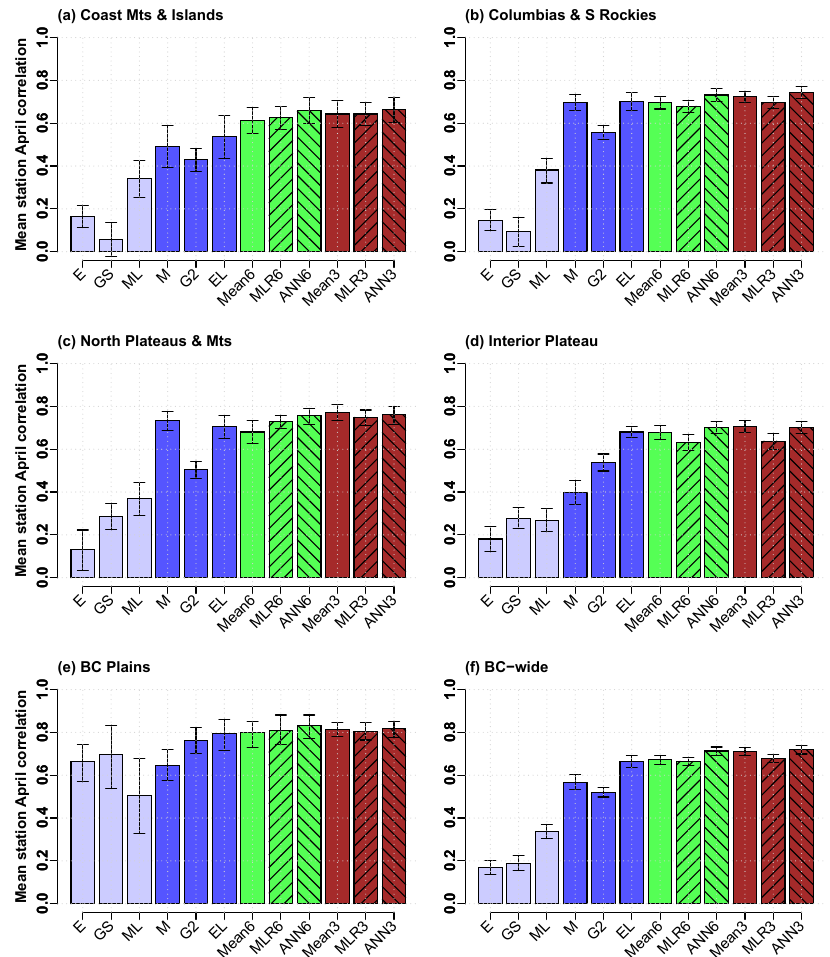
Figure 5. Mean station April correlation for several SWE products/combinations for regions of BC in order of descending mean accumula- tions: (a) Coast Mountains and Islands, (b) Columbia Mountains and Southern Rockies, (c) Northern Plateaus and Mountains, (d) Interior Plateau, (e) BC Plains, and (f) province-wide. Product and combination abbreviations and colors are as in Fig. 4.